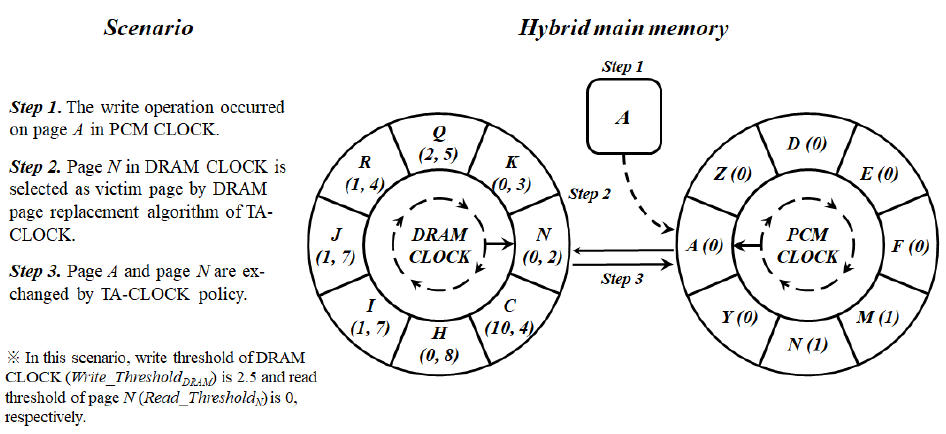
Figure 4. Example of page allocation in the DRAM CLOCK and page eviction from the DRAM CLOCK to the storage.